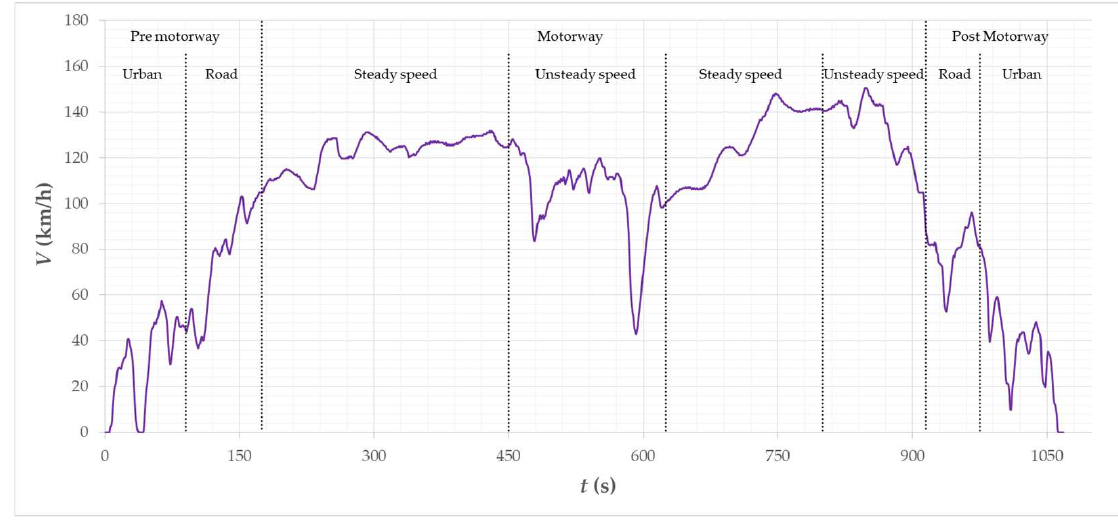
Figure 30. Vehicle speed waveform of the Artemis Motorway150 cycle .